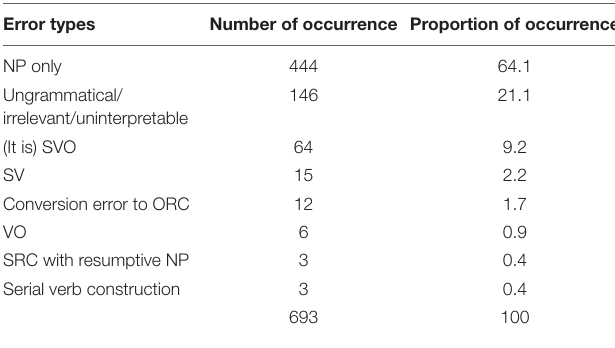
TABLE 5 | Distribution of error types in the SRC